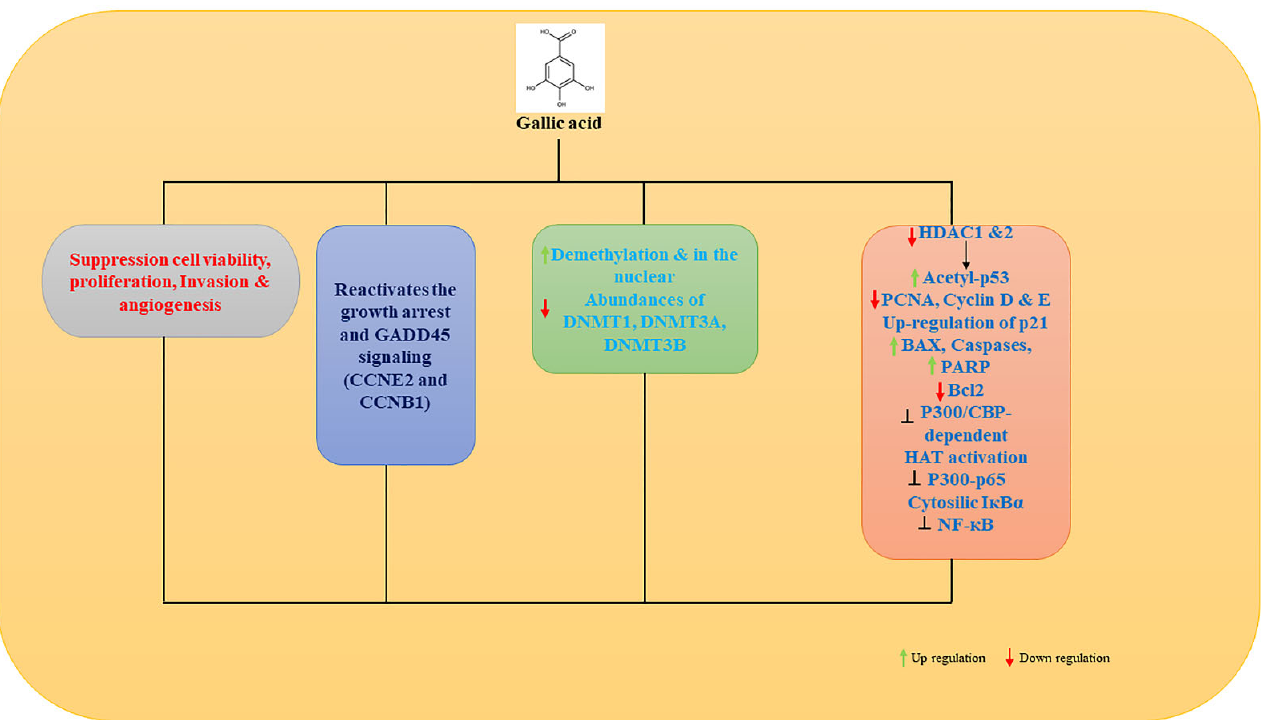
Figure 2. Gallic acid protects from cancer. Gallic acid suppresses cell viability, proliferation, inva ‐ sion, and angiogenesis; reactivates growth arrest and GADD45; increases demethylation and in ‐ creases the DNMT1, DNMT3A, and DNMT3B found to be more in the nucleus; decreases HDAC1 and 2; increases acetyl ‐ p53; decreases PCNA; cyclin D and E; up ‐ regulation of p21, decreases BAX, Cas3, and PARP, and increases Bcl2; inhibits P300/CBP ‐ dependent HAT activation; P300 ‐ p65 inhi ‐ bition; cytosolic IKB α ; inhibition of NF ‐ kB; and further protects from